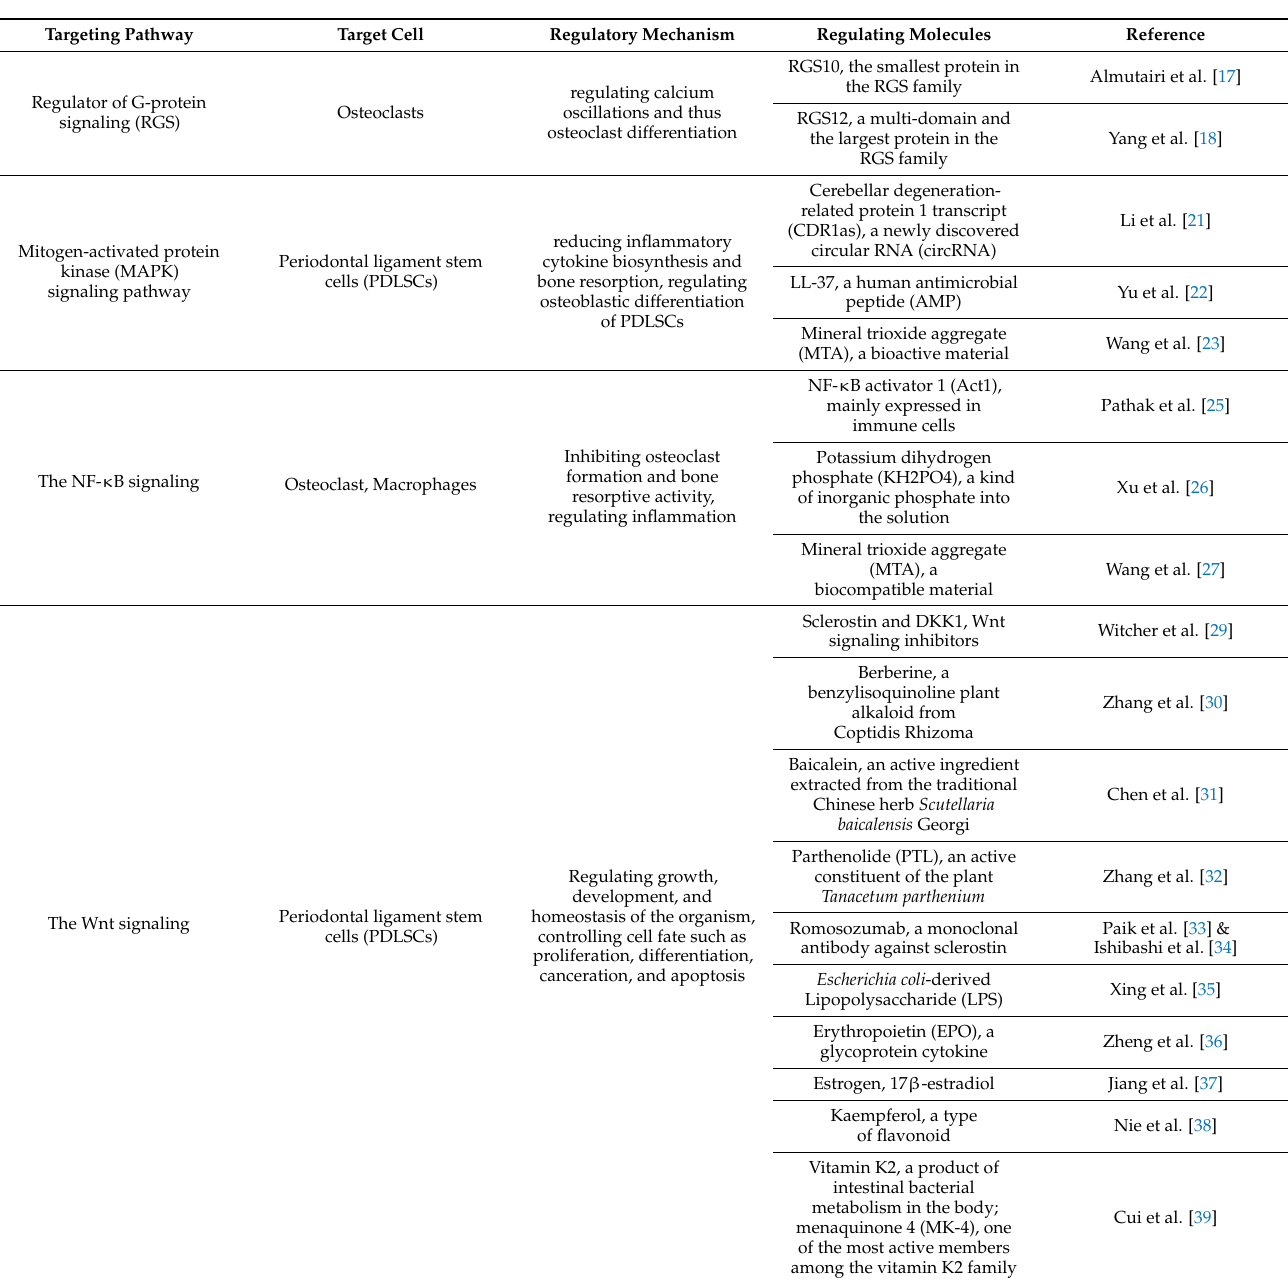
Table 1. Available targets in periodontal anti-inflammation and